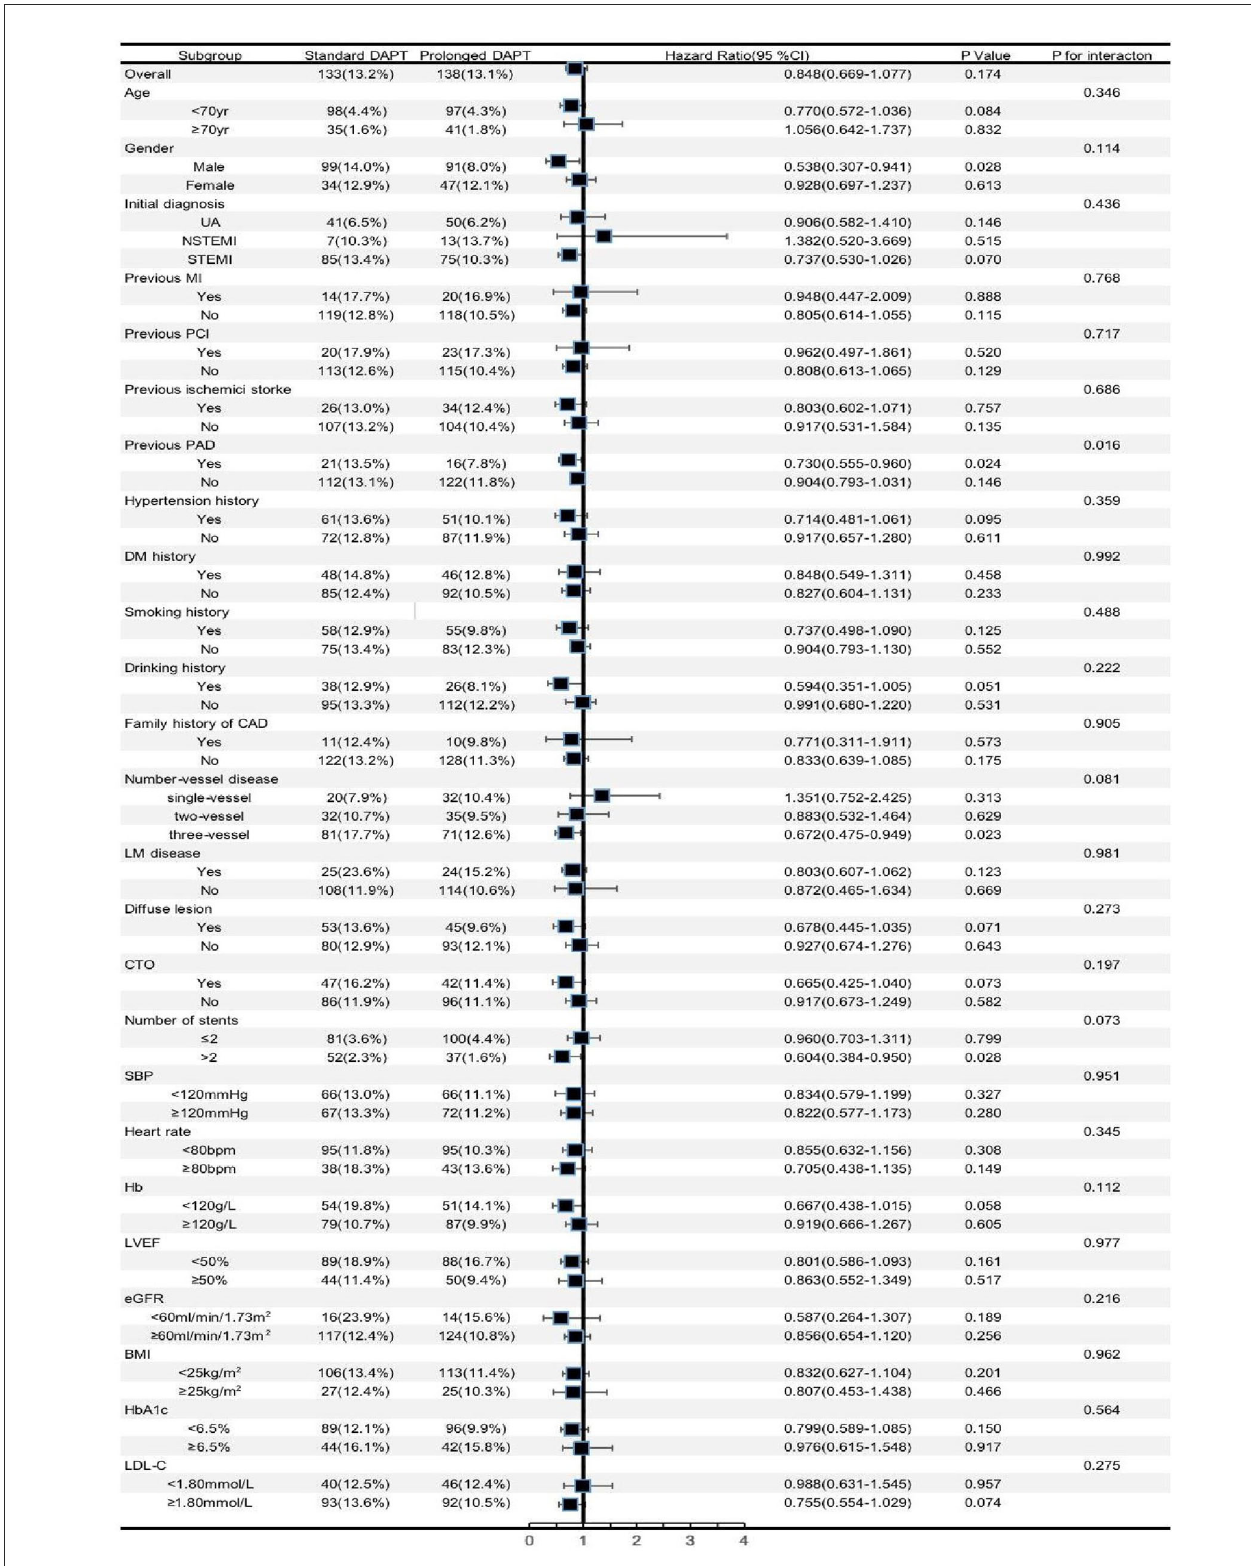
FIGURE2 Forest plot investigating the association between the DAPT duration and MACCEs in different subgroups. DAPT, dual antiplatelet therapy; UA, unstable angina; NSTEMI, non ST-segment elevation myocardial infarction; STEMI, ST-segment elevation myocardial infarction; MI, myocardial infarction; PCI, percutaneous coronary intervention; PAD, peripheral artery disease; DM, diabetes mellitus; CAD, coronary artery disease; LM, left main; CTO, chronic total occlusion; SBP, systolic blood pressure; Hb, hemoglobin; LVEF, left ventricular ejection fraction; eGFR, estimated glomerular filtration rate; BMI, body mass index; HbA1c, glycosylated hemoglobin A1c; LDL-C, low-density lipoprotein cholesterol; CJ, confidence